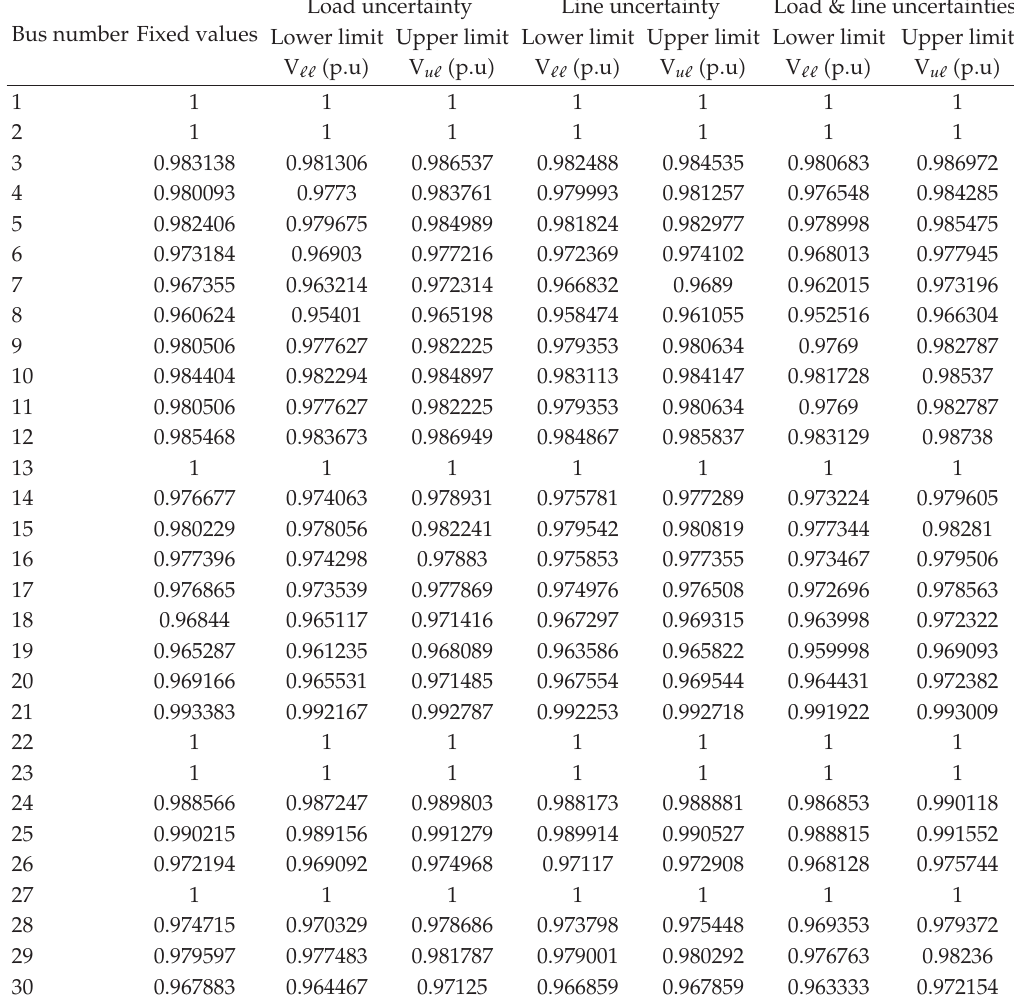
Table 2: Bus voltage magnitudes with di ff erent uncertainties.